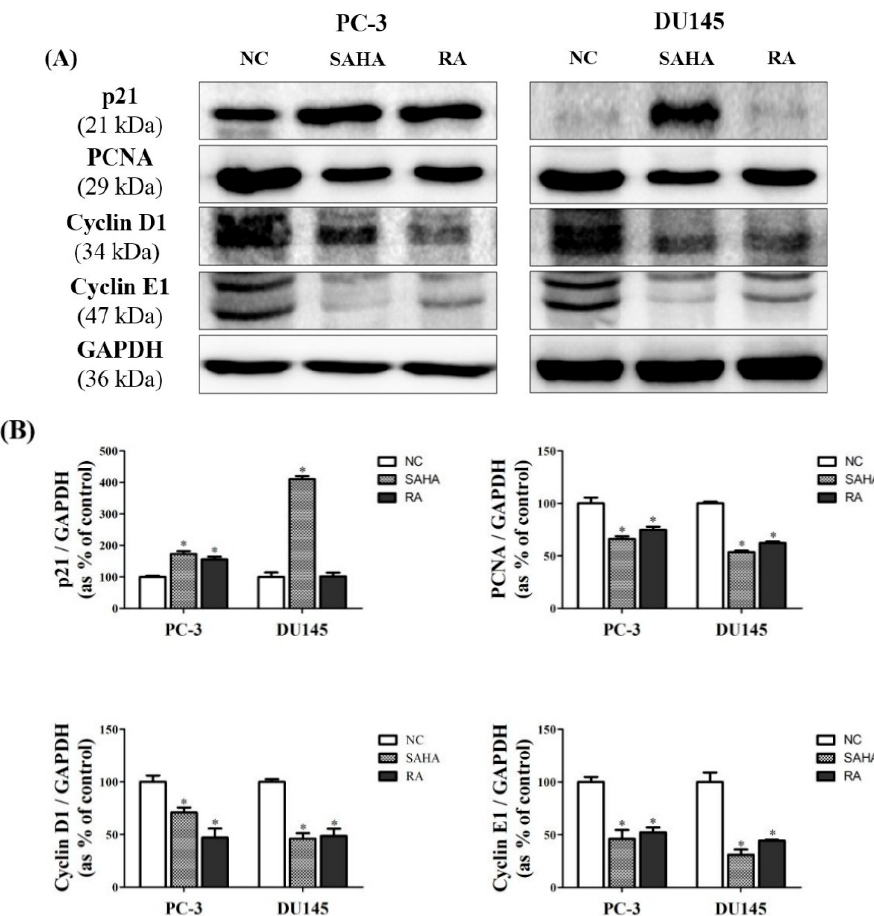
Figure 6. Effects of SAHA and RA on expression of cell cycle related genes in PC-3 and DU145 cell lines. After both cell lines were seeded at 1 × 10 6 in cell culture dishes and treated with media containing NC (DMSO), SAHA (1 µ M) and RA (200 µ M), the western blot analysis was performed. ( A ) The expressions of p21, proliferating cell nuclear antigen (PCNA), cyclin D1 and cyclin E1 at the protein level were confirmed by western blot analysis. ( B ) The expression levels of each gene were quantified and normalized to GAPDH. The results are expressed as means ± SD. * p < 0.05: a significant difference versus control.